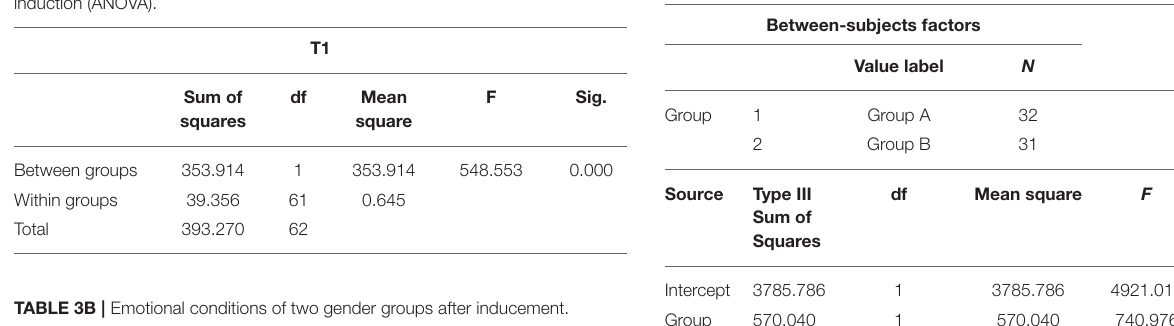
TABLE 4B | Tests of between-subjects effects.